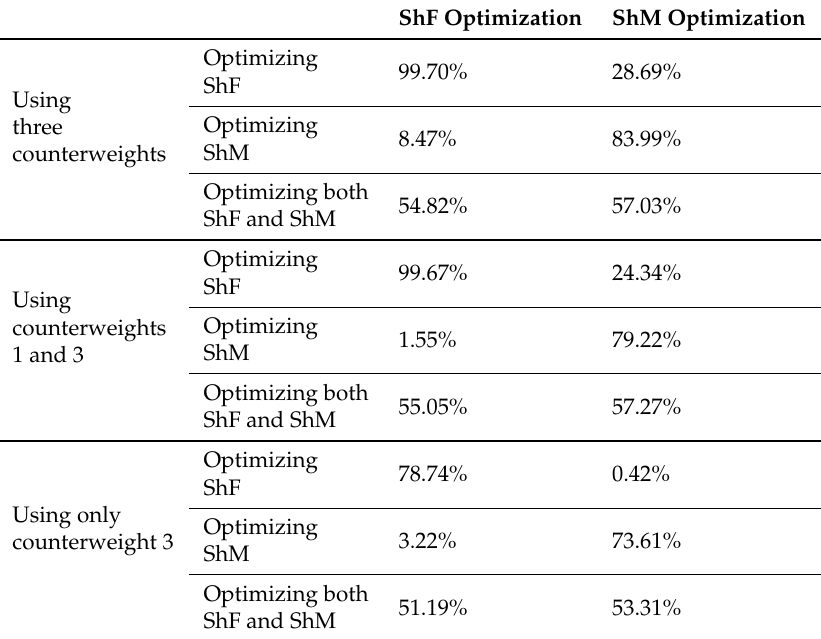
Table 2. Comparison between optimization results.